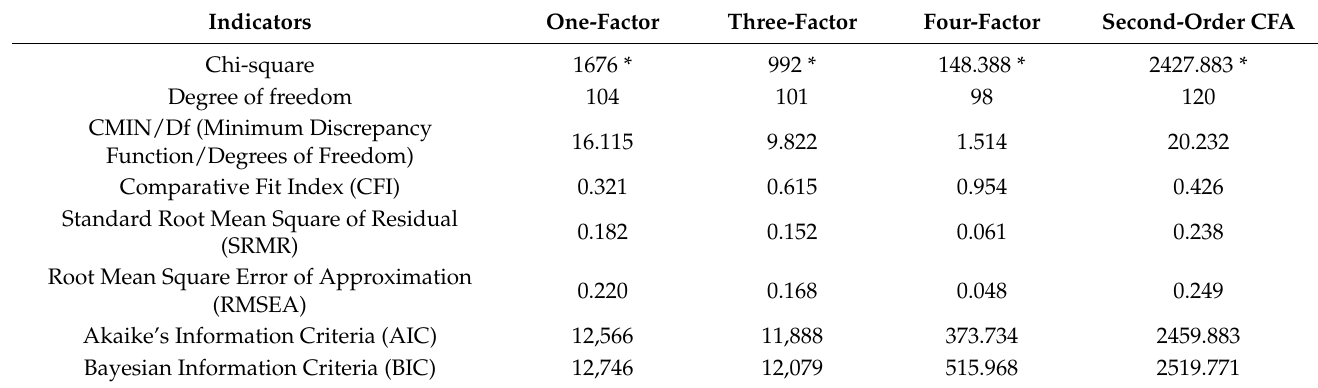
Table 3. Model Fit Indices for the one-factor, three-factor, four-factor and second-order CFA models.